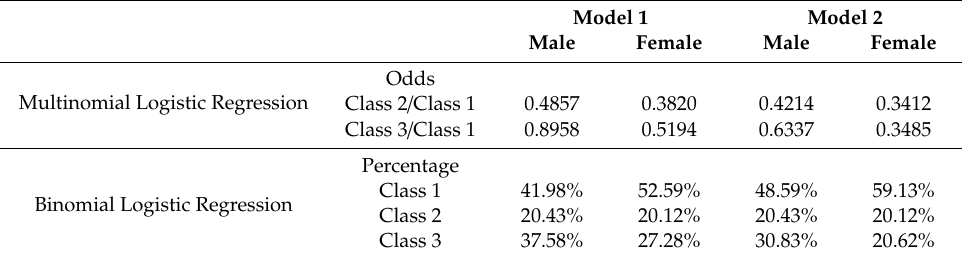
Table 2. Interpretation Forms of Estimated Logistic Regressions based on hard